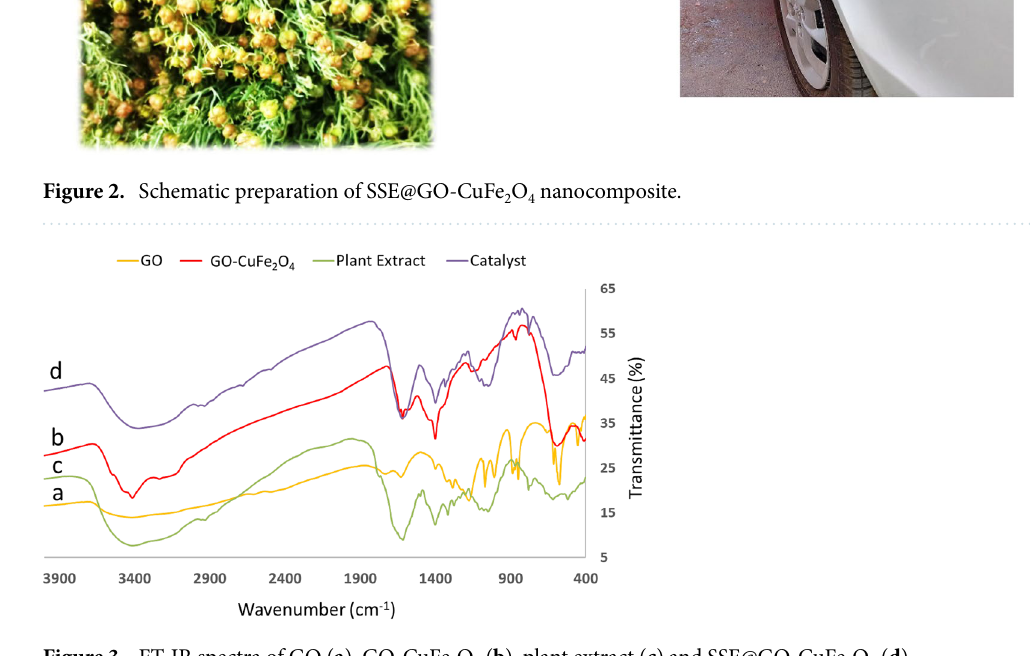
Figure 3. FT-IR spectra of GO ( a ), GO-CuFe 2 O 4 ( b ), plant extract ( c ) and SSE@GO-CuFe 2 O 4 ( d